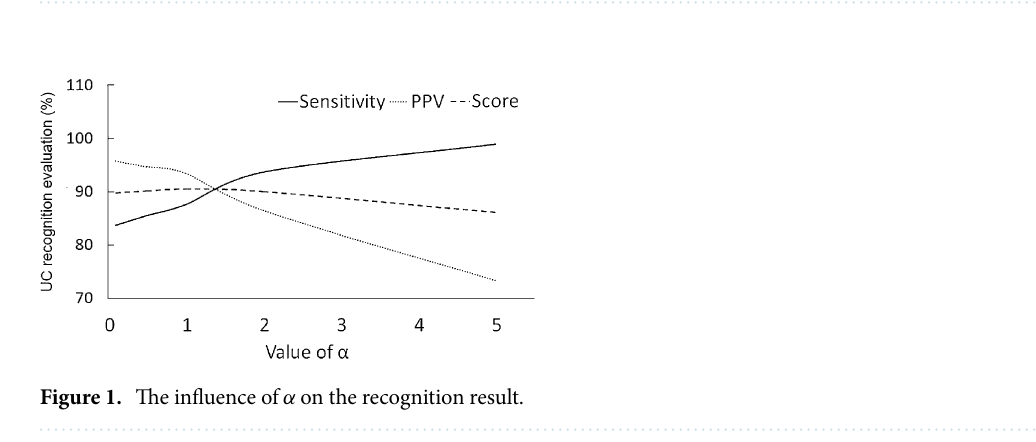
Table 3. UC parameters from preterm and term delivery.